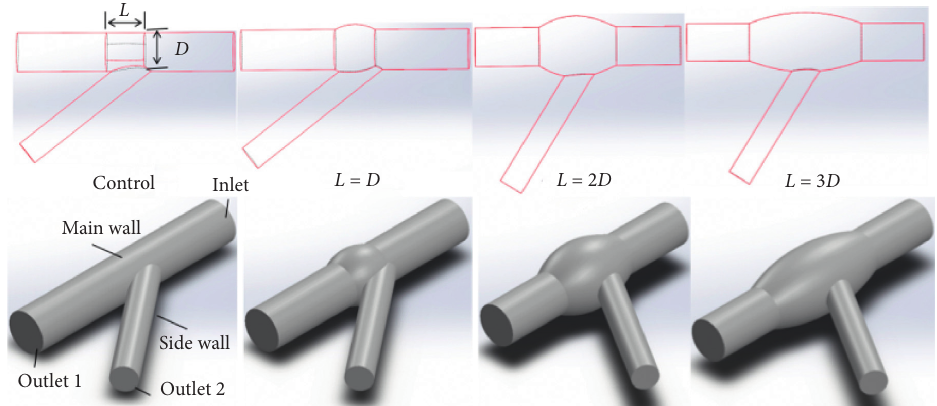
Figure 1: Schematic diagram of a vessel with enlarged segment at branch after the intervention of vascular stent. Table 1: Geometry parameters of enlarged vessels. Main vessel